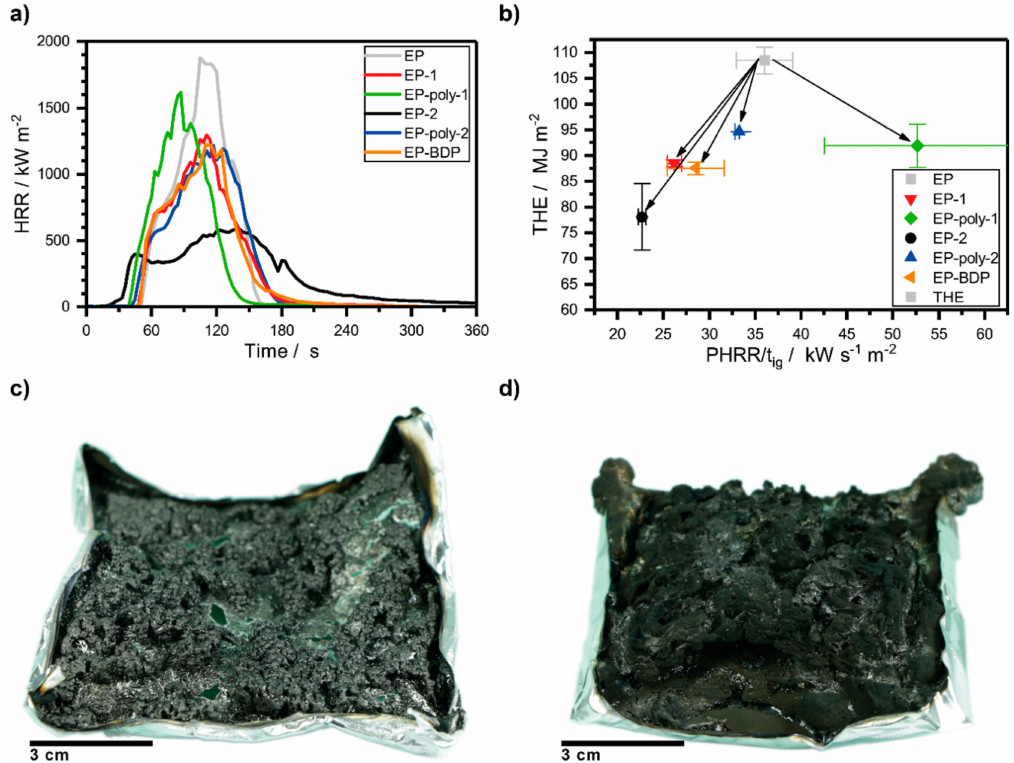
Figure 4. (a ) Heat release rate (HRR) of epoxy resin and epoxy resin with flame retardants (FRs) measured by cone calorimeter. ( b ) Petrella plot of the di ff erent epoxy resins with all FRs having a positive e ff ect (lowering total heat evolved (THE)), especially 2. ( c ) Residue of EP-poly-1 after cone calorimeter measurement, presenting a high graphitic residue yield but poor protective layer. ( d ) The residue of EP-poly-2 after cone calorimeter measurements, presenting a good protective layer by the production of voluminous, multicellular